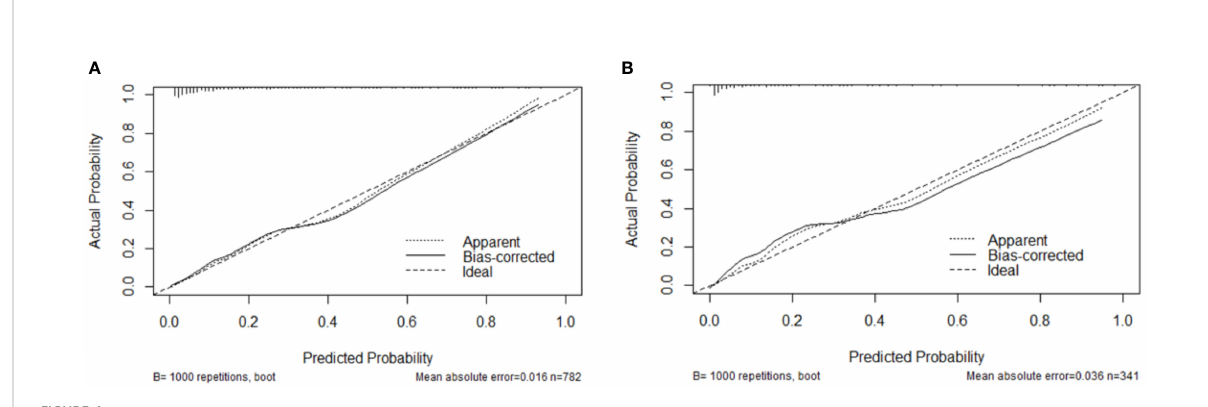
FIGURE 4 Calibration plots of the nomogram in the development (A) and validation (B)